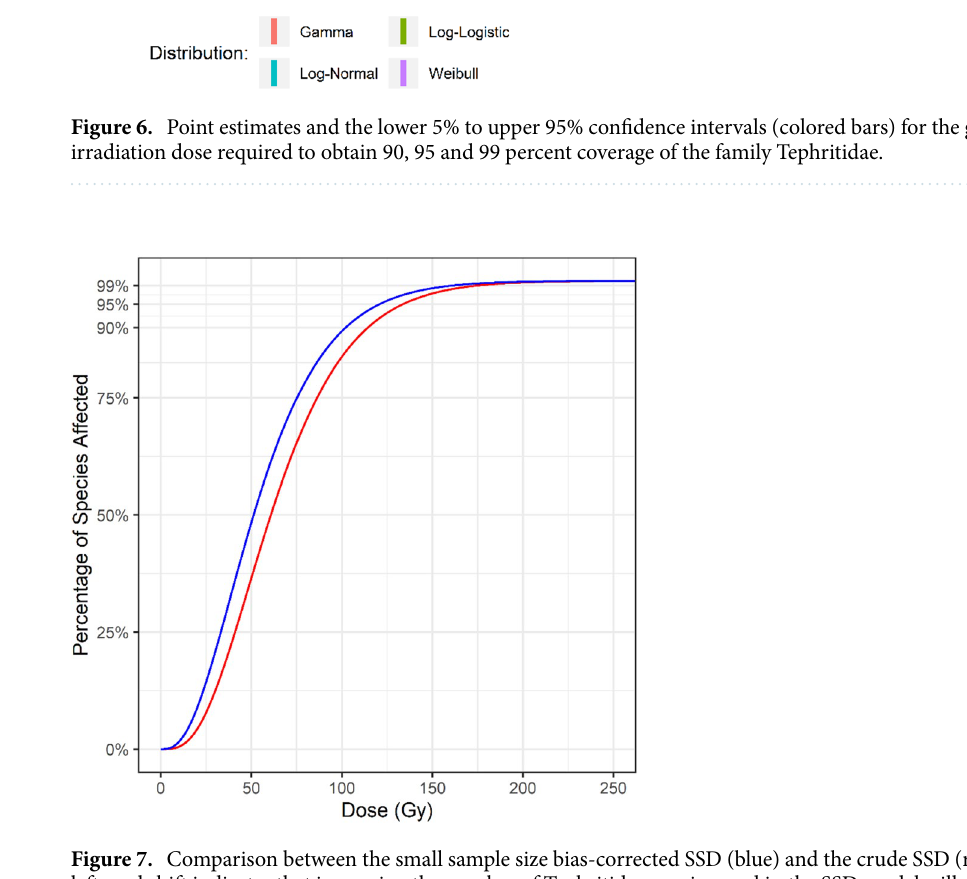
Figure 7. Comparison between the small sample size bias-corrected SSD (blue) and the crude SSD (red). The leftward shift indicates that increasing the number of Tephritidae species used in the SSD model will result in a reduction in the required generic